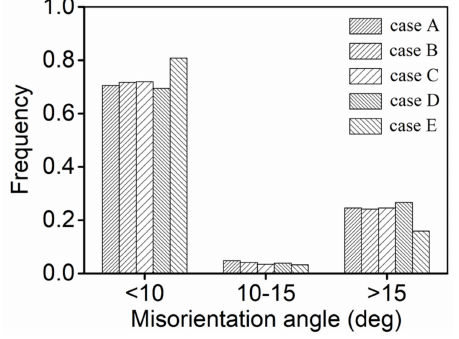
Figure 7. Frequency of misorientation angles during double-stage hot forming. (Here, cases A, B, C, D, and E are represented as the tested conditions of 890 ◦ C/ 0.1 s − 1 / ε I = 0.3/0.001 s − 1 , 920 ◦ C/0.1 s − 1 / ε I = 0.3/0.001 s − 1 , 950 ◦ C/0.1 s − 1 / ε I = 0.3/ 0.001 s − 1 , 920 ◦ C/ 0.1 s − 1 / ε I = 0.9/0.001 s − 1 . 920 ◦ C/0.1 s − 1 / ε I = 0.3/1 s − 1 ,